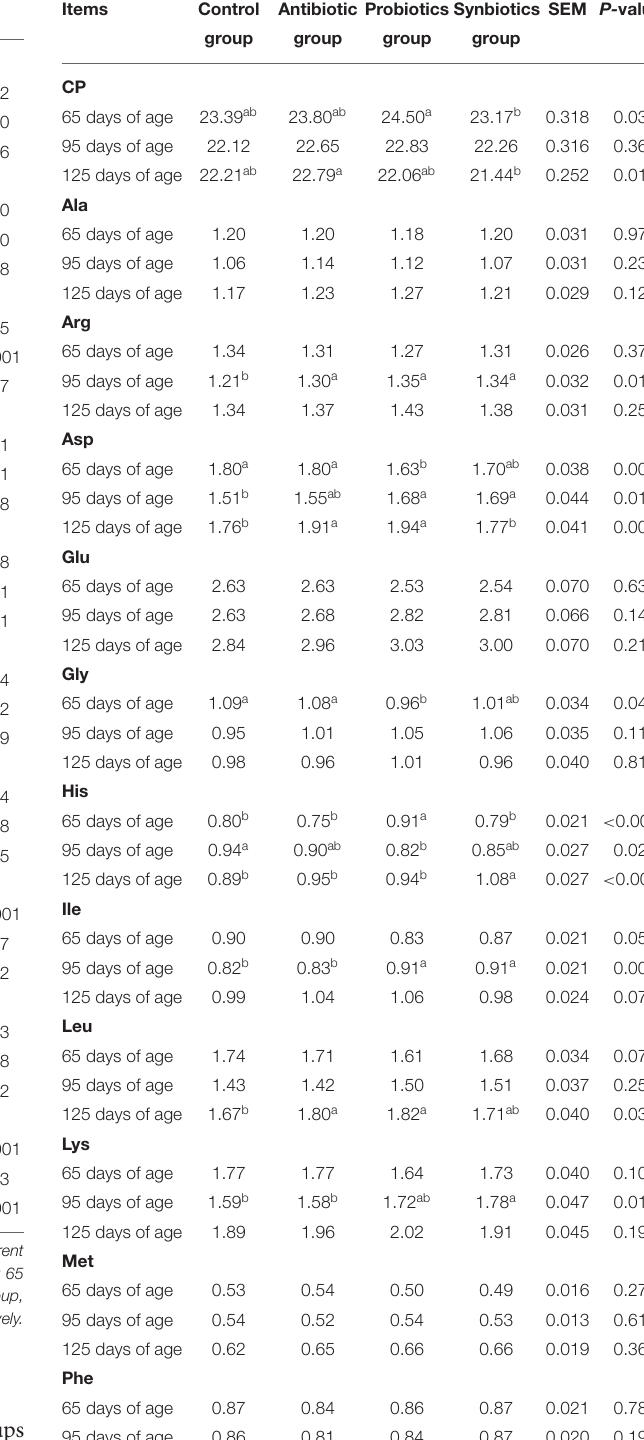
TABLE 3 | Effects of probiotics and synbiotics addition in sows’ diets on meat quality of offspring pigs. Items Control Antibiotic Probiotics Synbiotics SEM P- values